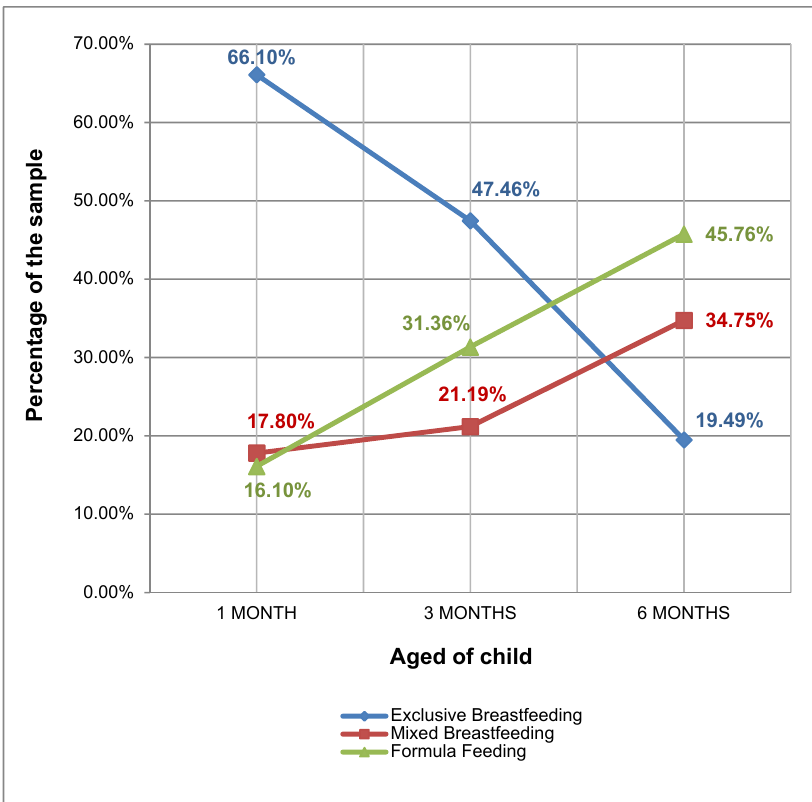
Figure 2. Prevalence of breastfeeding types for 6 months.